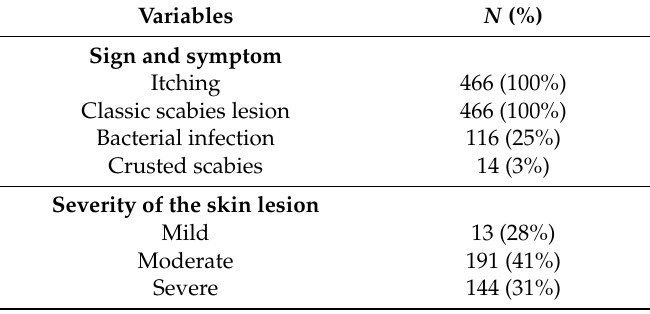
Table 3. Clinical signs and symptoms of scabies cases in the Amhara region, Ethiopia (2015).